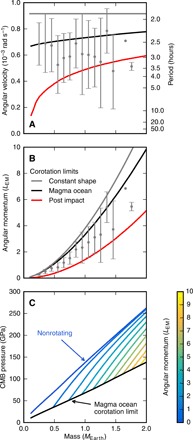
The rotation rates expected during the giant impact stage of planet formation could substantially reduce the internal pressures in bodies of a wide range of masses.(A) The angular velocity of different mass bodies at the end of accretion as calculated in (3) (gray points and bars). The bars are the 1σ standard deviation in the rotation rates found in their simulations. The gray line gives the critical angular velocity for breakup of a rigid, spherical body of bulk density 3000 kg m−3 as used in (3). The black and red lines give the CoRoL calculated using HERCULES for magma ocean planets and substantially vaporized, thermally stratified bodies, respectively. (B) AM of different mass bodies as calculated in (3) (gray points and bars). Notations and lines are the same as in (A) but in AM space. (C) Pressure at the CMB for Earth-like, magma ocean planets of different masses and AM in increments of 1 LEM (colors) calculated using HERCULES. The black line gives the pressure at the CoRoL for a magma ocean planet.